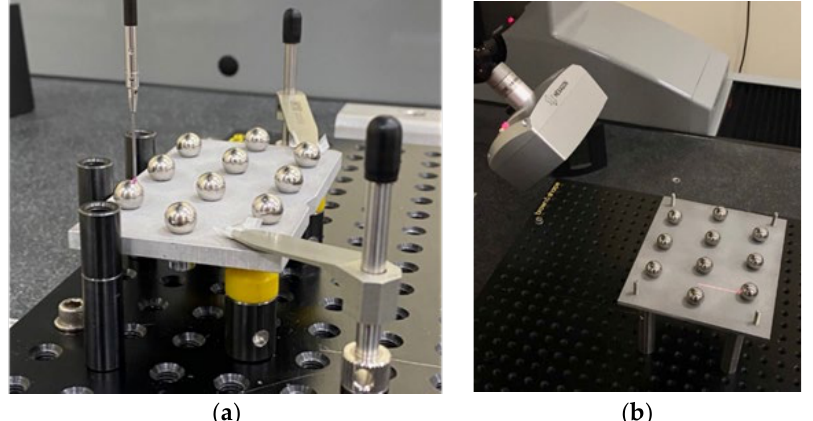
Figure 5. ( a ) Modular fixture for contact measurements. ( b ) Fixture by simple support for noncontact measurements.